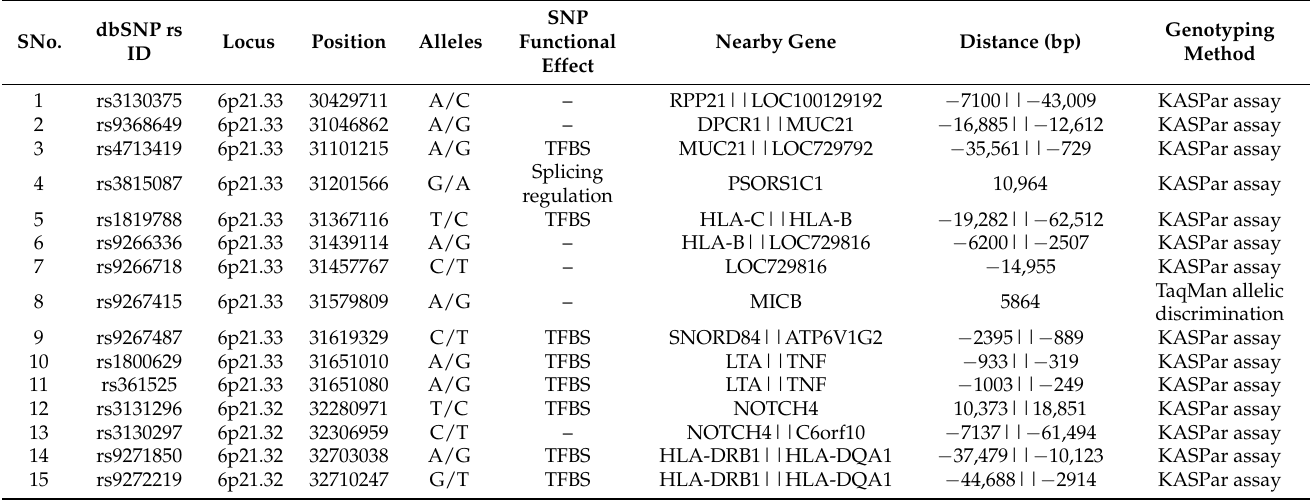
Table 1. SNPs in the HLA region, functional effect, and the genotyping method.